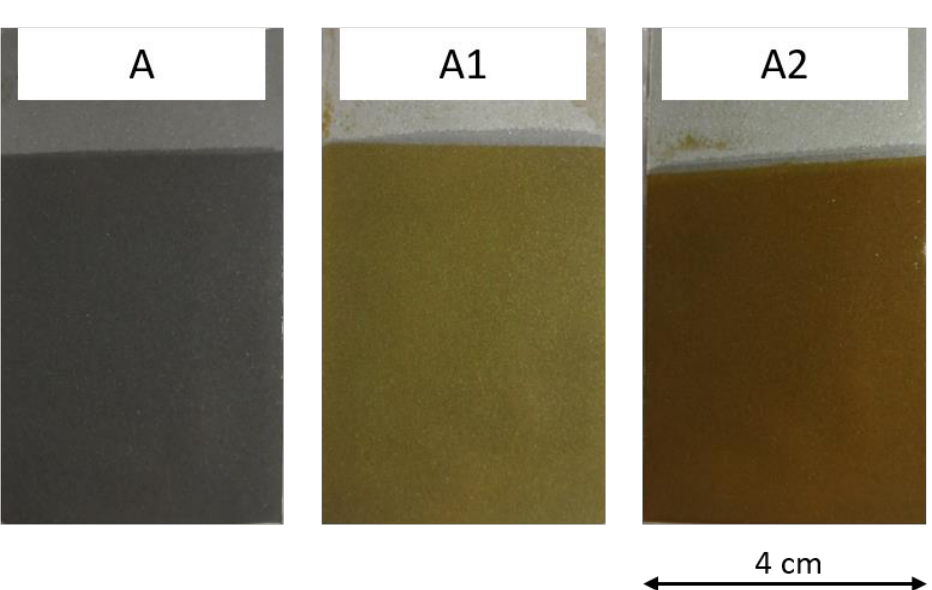
Figure 3. Photograph of the three as-made sample series, where A represents the coating of pure acrylic matrix, while A1 and A2 were deposited by introducing 0.05 wt.% and 0.10 wt.% of colloidal silver in the cataphoretic bath, respectively.